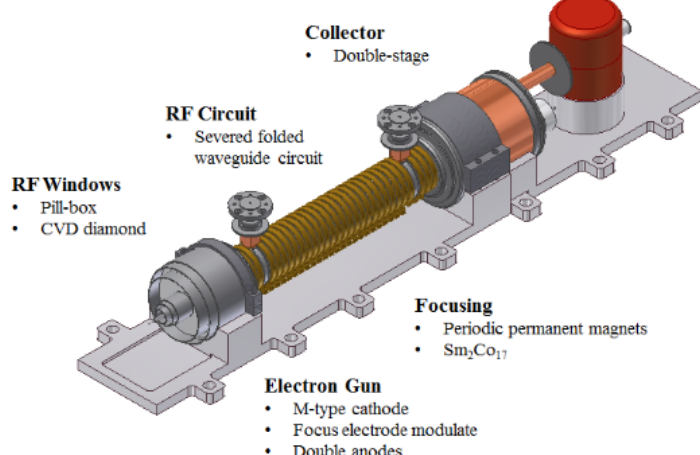
and current of the TWT are 20 kV and 50 mA with a beam radius of 0.06 mm and a beam-